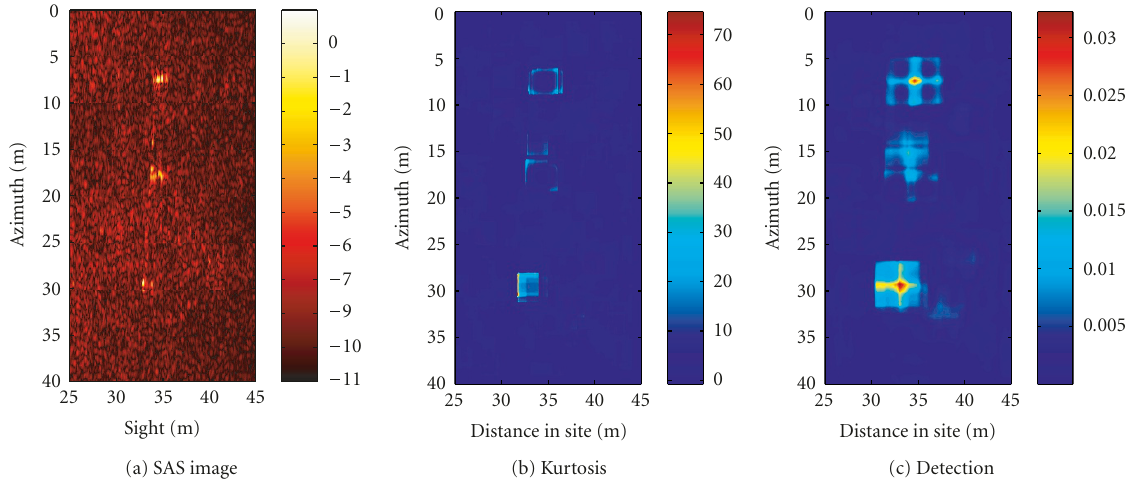
Figure 21: Detection on the third SAS data (kurtosis 55 × 55, matched filtering 63 × 63, SD = 3).